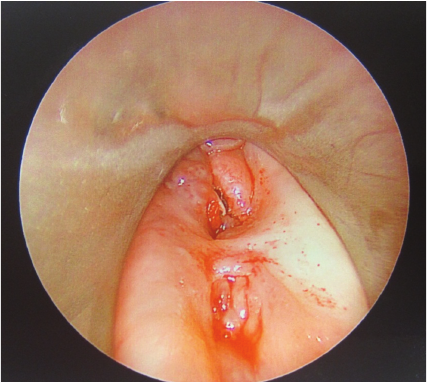
Figure 3: Direct laryngoscopy with telescopic visualization of pharyngeal defect with exposed